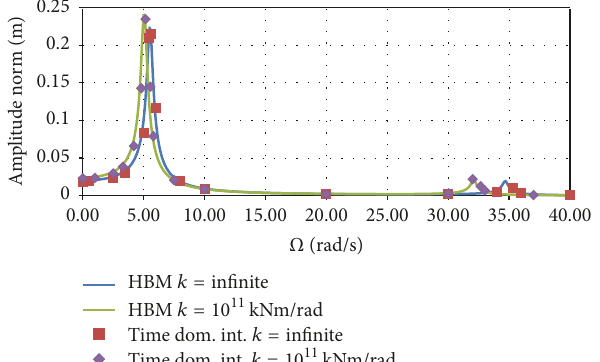
Figure 2: Variation of the maximum displacement at the top of the tower as a function of the forcing frequency Ω obtained with the harmonic balance method (HBM) and with time domain integration. 𝐴 𝑥 = 0.8𝑔 .